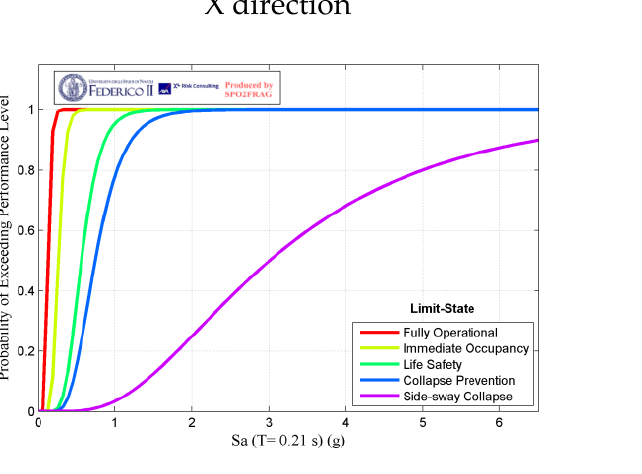
Figure 11. Maximum principal plastic strains (associated with tensile cracks) of the CM models at the end of analyses: ( a ) Type − 1; ( b ) Type − 2; ( c ) Type − 3; ( d ) Type − 4.